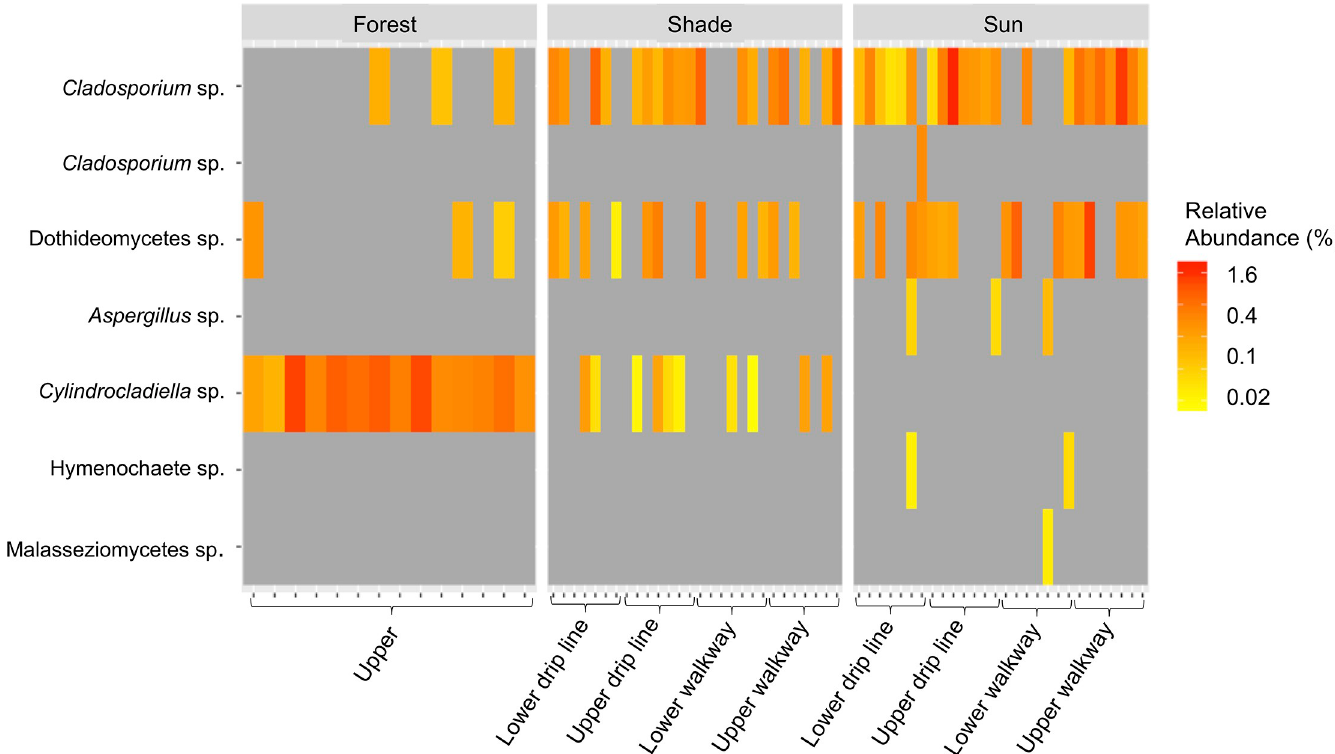
Fig 3. Heatmap of biofertilizer fungal taxa found in forest and coffee